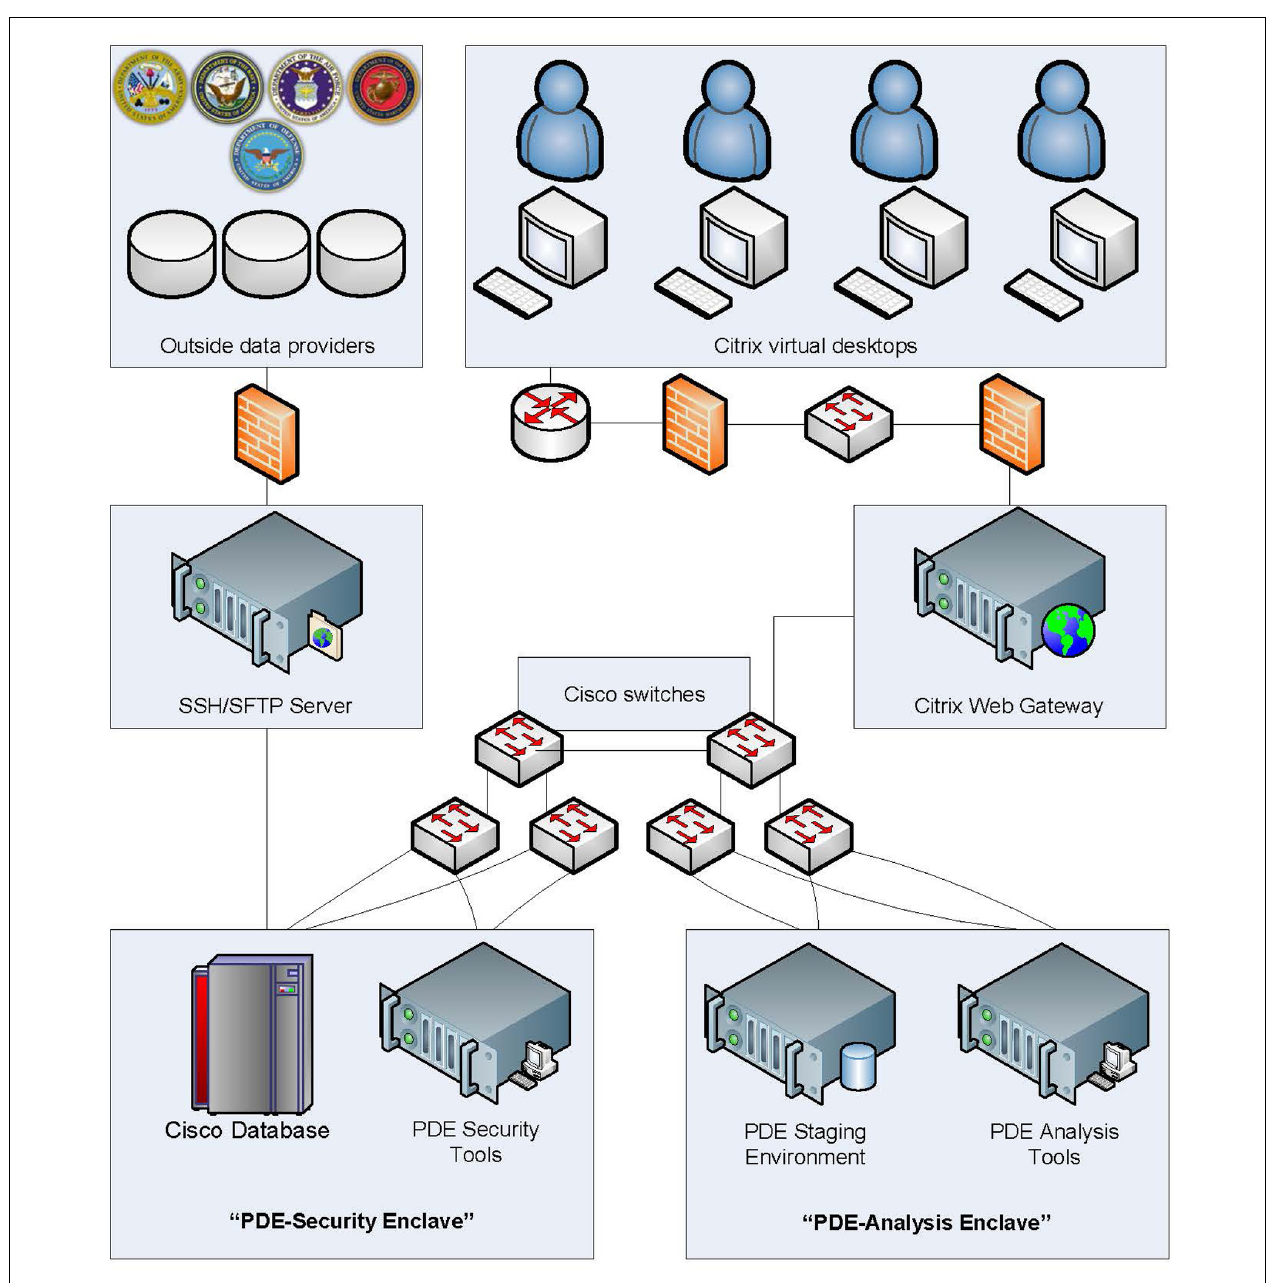
FIGURE 1 | PDE system